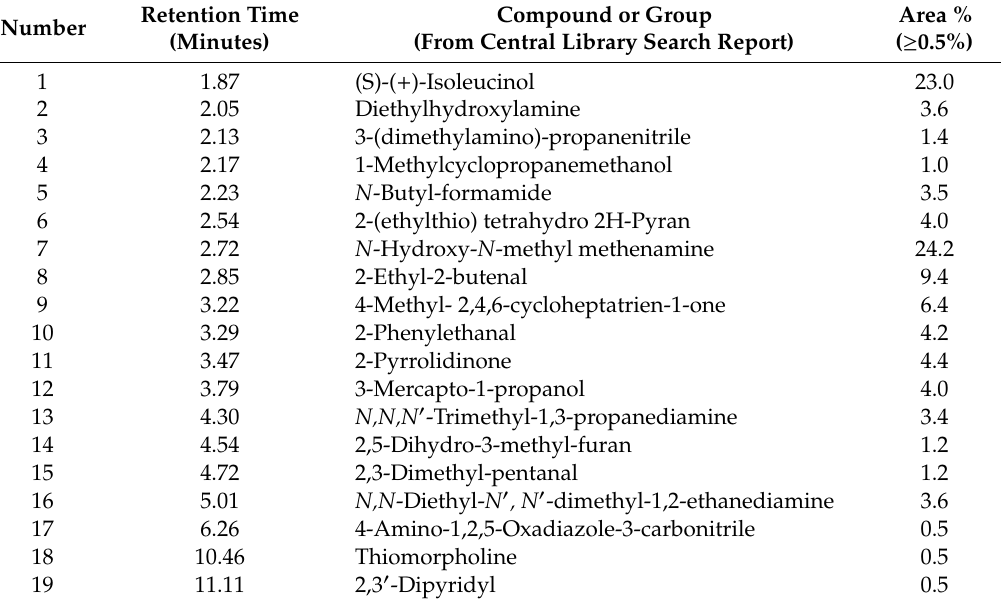
Table 2. Chemical composition of P. ostreatus aqueous extract as detected by GC-MS analysis.